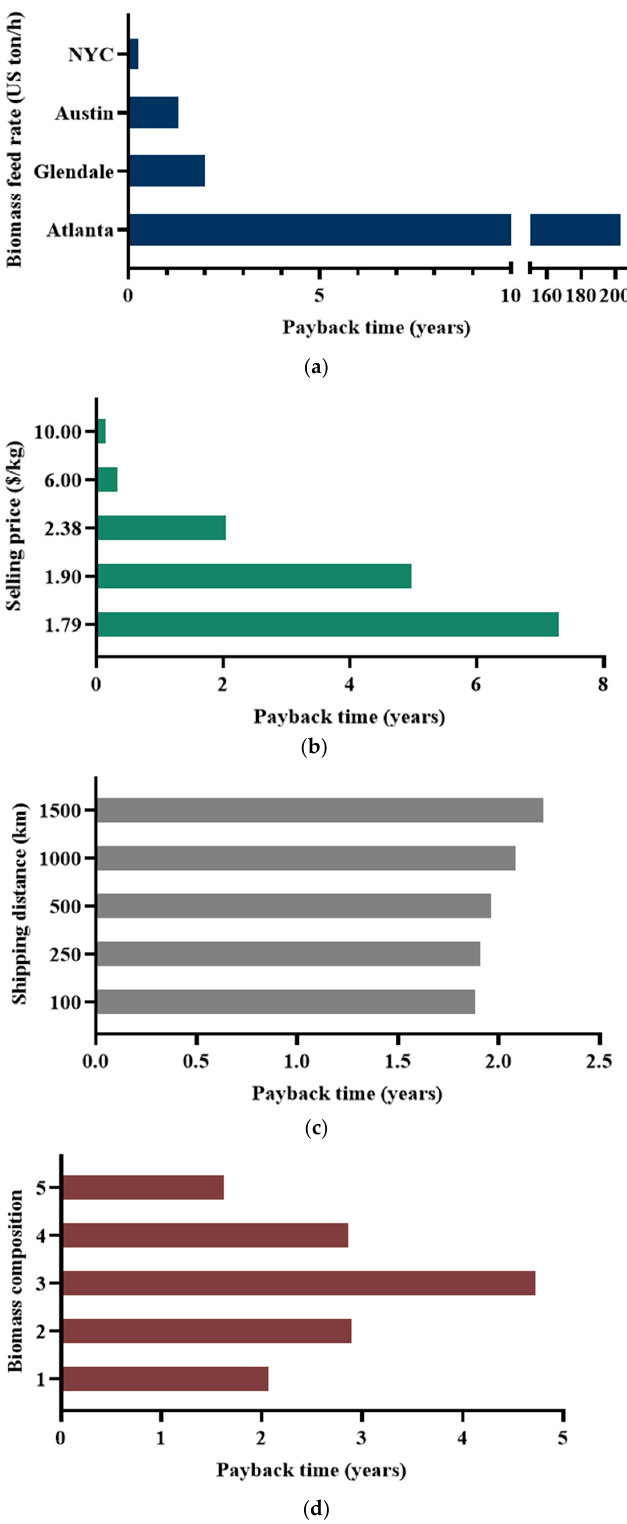
Figure 3. ( a ) The effect of biomass feed rate and city size on payback time. ( b ) The effect of selling price on payback time. ( c ) The effect of shipping distance on payback time. ( d ) The effect of biomass composition on payback time.